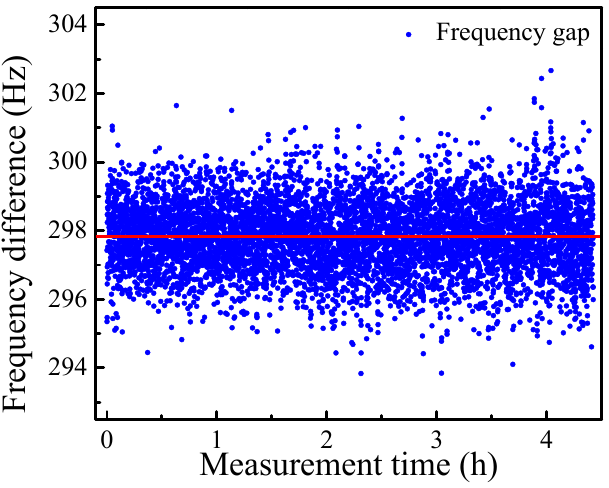
Figure 4. The frequency gap between m F = +9/2 and m F = − 9/2 during closed-loop operation of the clock using the DISC method. The red solid line indicates the average gap by linearly fitting the experimental data. The magnetic field drift rate is − 4(6) × 10 − 6 mG/s extracted from the experimental data, where the uncertainty indicates the 95% confidence interval and the magnetic field drift rate agree with zero.